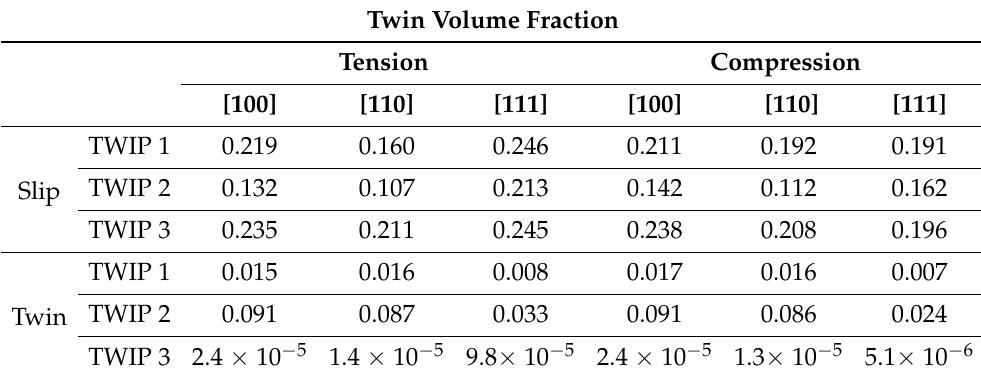
Table 5. Shear strain’s magnitude at 0.4 equivalent strain in slip and twin modes of TWIP 1, 2, and 3 steels under tension and compression.